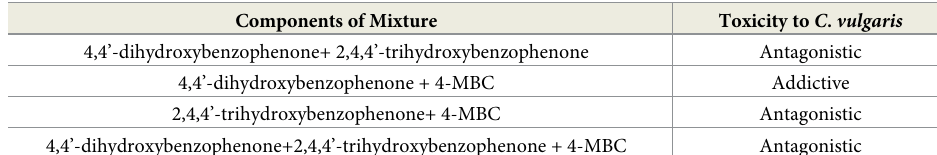
Table 5. Toxicity results of mixtures to C . vulgaris .